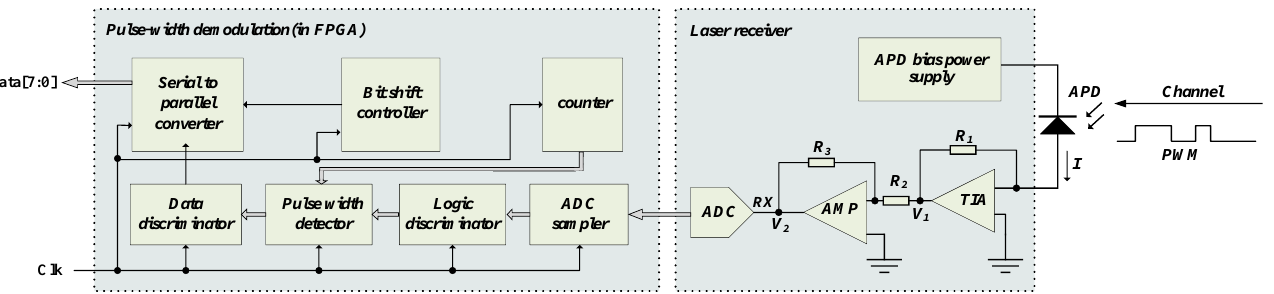
Figure 10. Pulse width demodulation and receiving circuit. In the PWM demodulator, the ADC sampler drives ADC to sample the RX signal. The logic discriminator judges the logic level according to the data obtained. When logic level 1 is detected, the counter starts counting. When logic level 0 is detected, the counter stops counting. At the same time, the pulse width detector counts the logic judgment re- sults, the data discriminator judges the data according to the statistical results of the pulse width detector, and finally converts the serial 8-bit data to the parallel 8-bit data output through the shift controller and data converter. 3. Experiment and Analysis Figure 11 shows the test diagram of the point-to-multipoint free-space optical com- munication system. We mainly verified that the data at the transmitting end were sent to the receiving end in different directions through the repeater. Considering the production cost and the convenience of the test, we created a simple optical communication system that can send and receive data in six directions. We completed the basic prototype of the optical communication network group technology and verified it. The system mainly in- cluded a laser transmitter, a communication relay and three laser receivers. The hardware circuit mainly included a laser transmitting circuit, a laser receiving circuit and a system